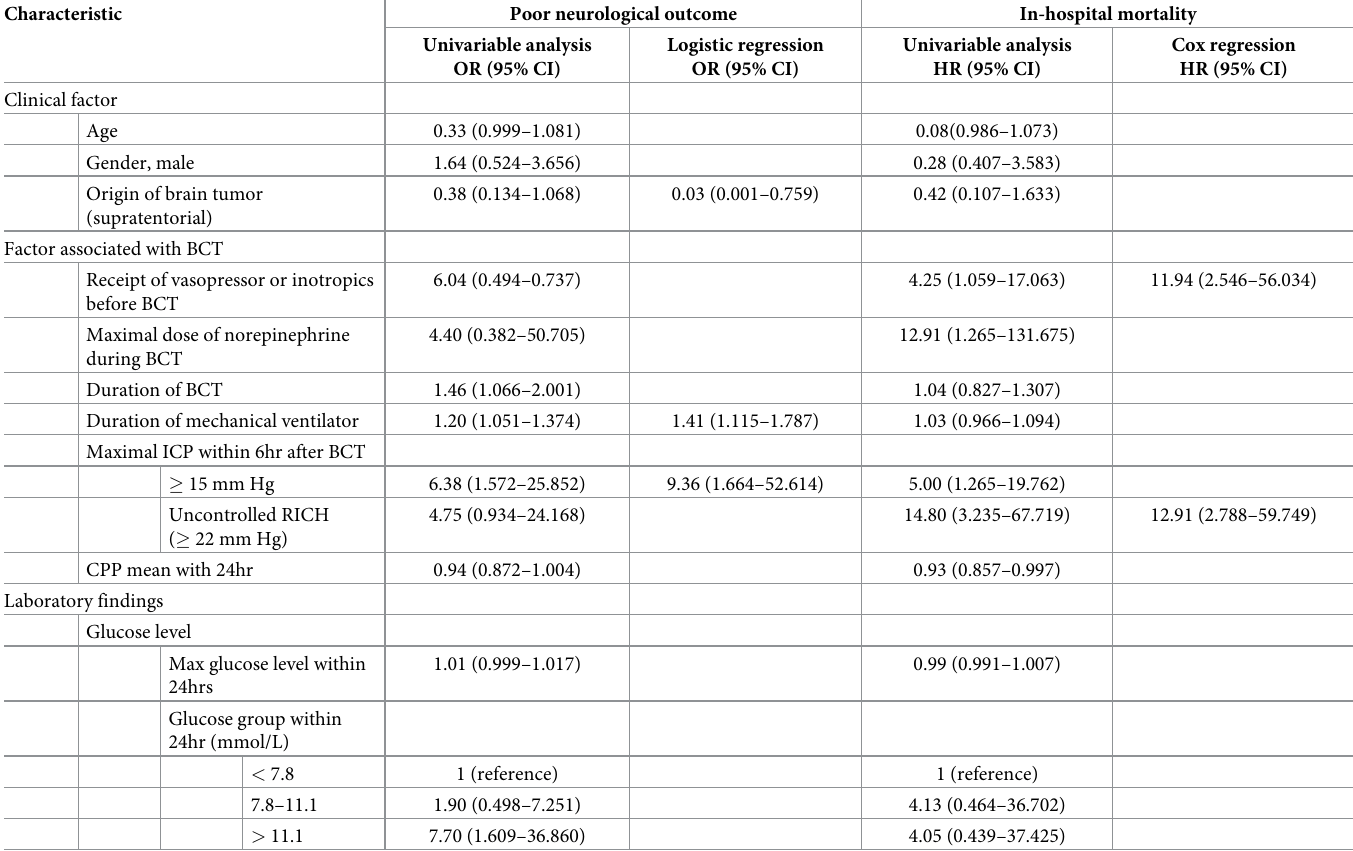
Table 4. Univariable and multivariable analyses of factors associated with clinical